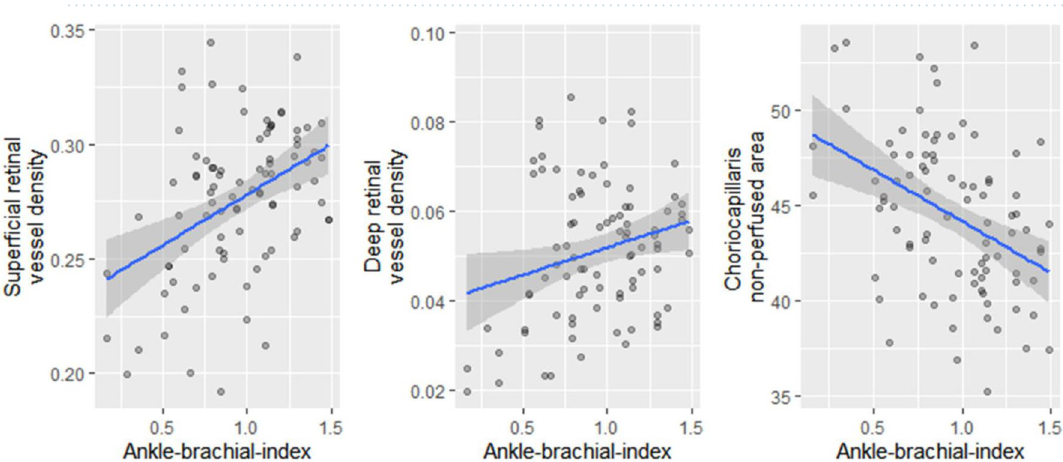
Figure 2. Correlation of retinal and choriocapillaris perfusion with ankle-brachial-index. Vessel density on OCT-A in the superficial and deep retina and choriocapillaris non-perfused area were plotted against ankle- brachial-index. The blue line represents a linear regression model with the surrounding confidence interval in light